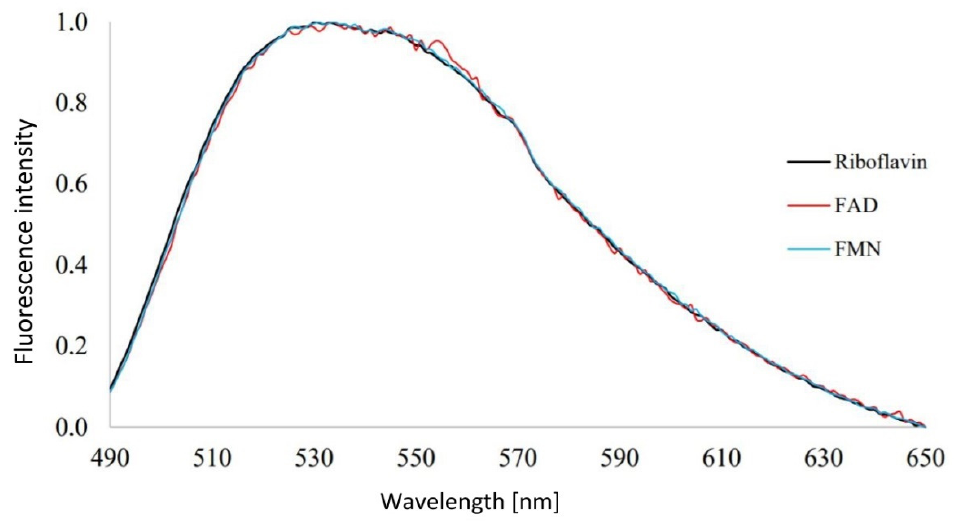
Figure 1. Emission spectra of the flavin standards. Excitation 467 nm, the concentration of the aqueous solution 10 − 6 mmol in 25 mL Erlenmeyer flasks, stored at 4 °C, in the dark, at lab temperature. FMN, flavin mononucleotide; FAD, flavin adenine nucleotide.